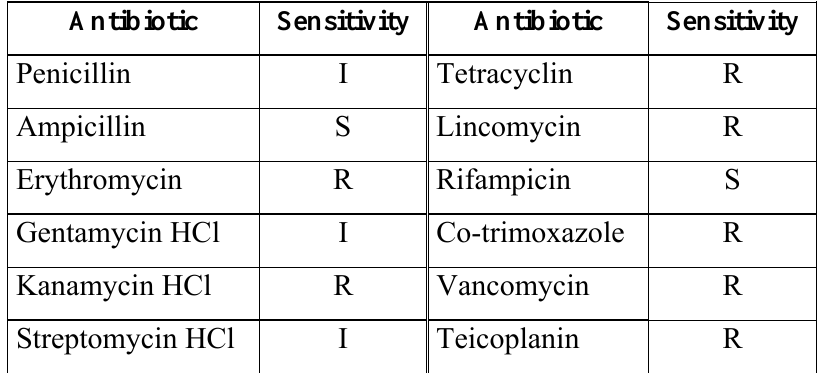
Table 10. Antibiotic sensitivity pattern of Enterococcus faecalis strain isolated from